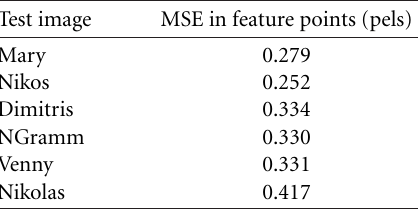
Table 2: FPD method deformation error, measured in the projected positions of the feature